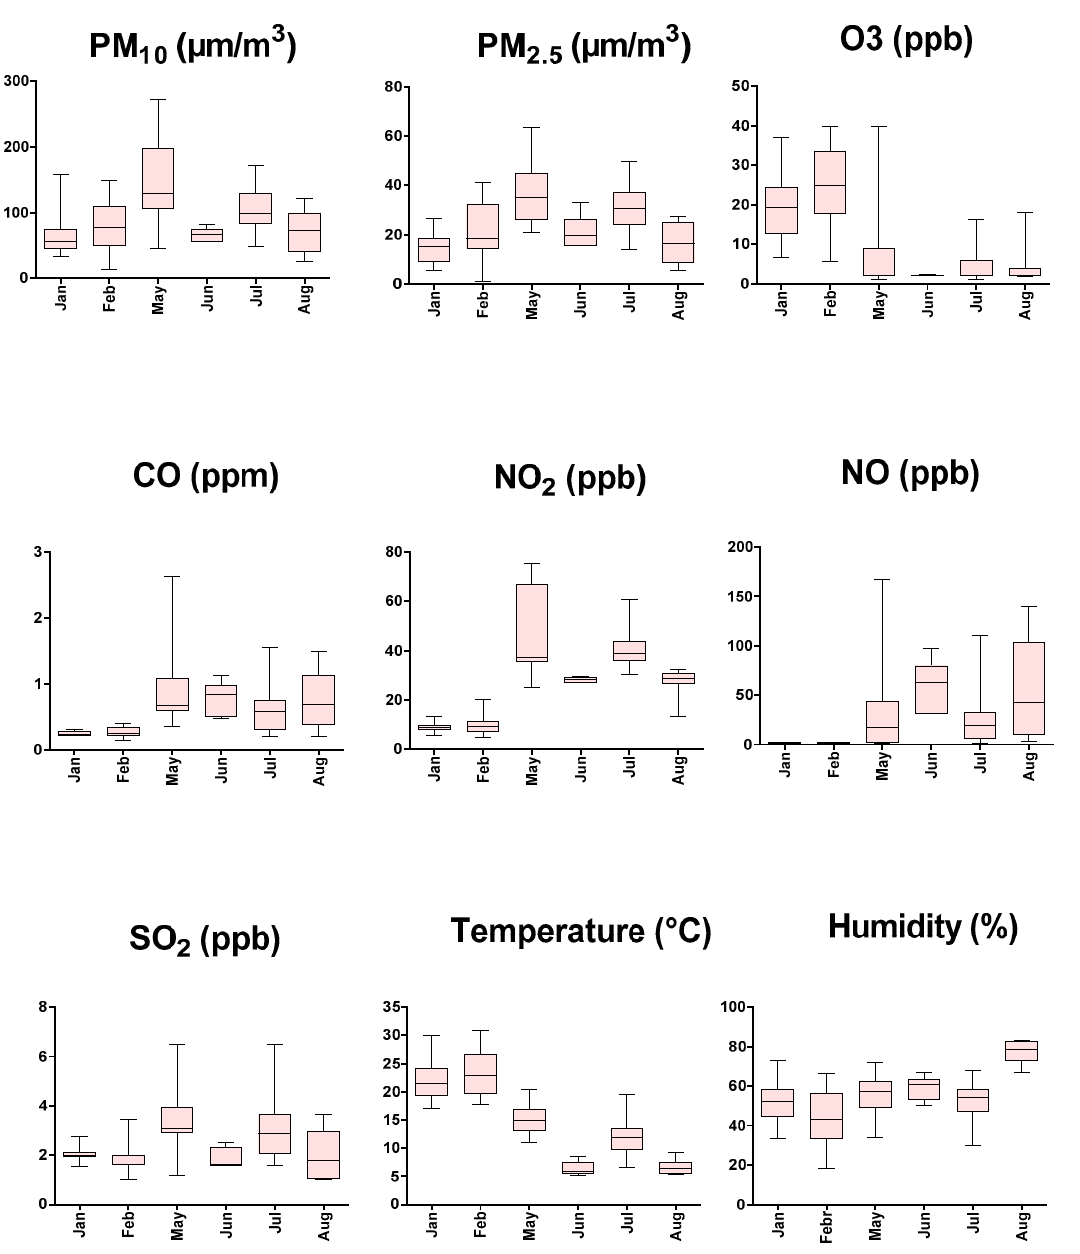
Figure 2. Air pollutant concentration, temperature, and humidity at the moment of races. Data are presented as box plots. The box consists of the first quartile, median and third quartile values, while the upper and lower horizontal lines are the minimum and maximum values, respectively. Statistical analysis is presented in Tables S2 and S3 of the Supplementary Material. Table 1. Pearson correlation coefficients for temperature, humidity, and pollutant concentration. The values in bold type have a p -value lower than 0.05.